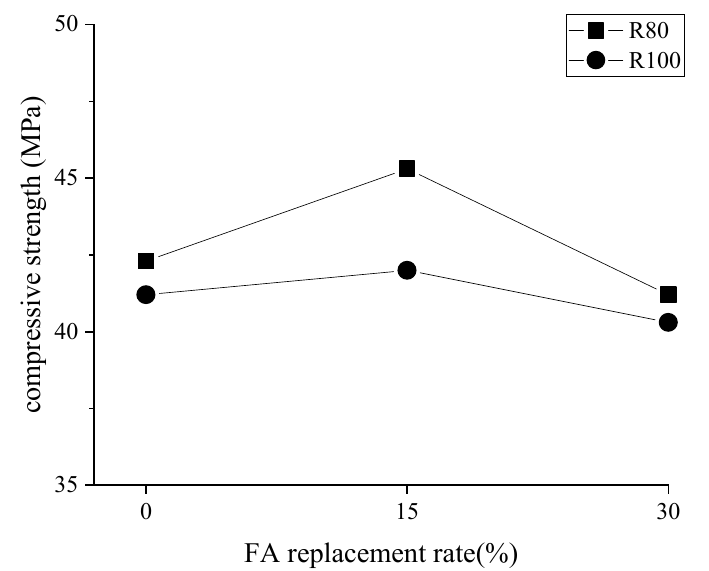
Figure 6. Twenty-eight-day compressive strength in different FA content.